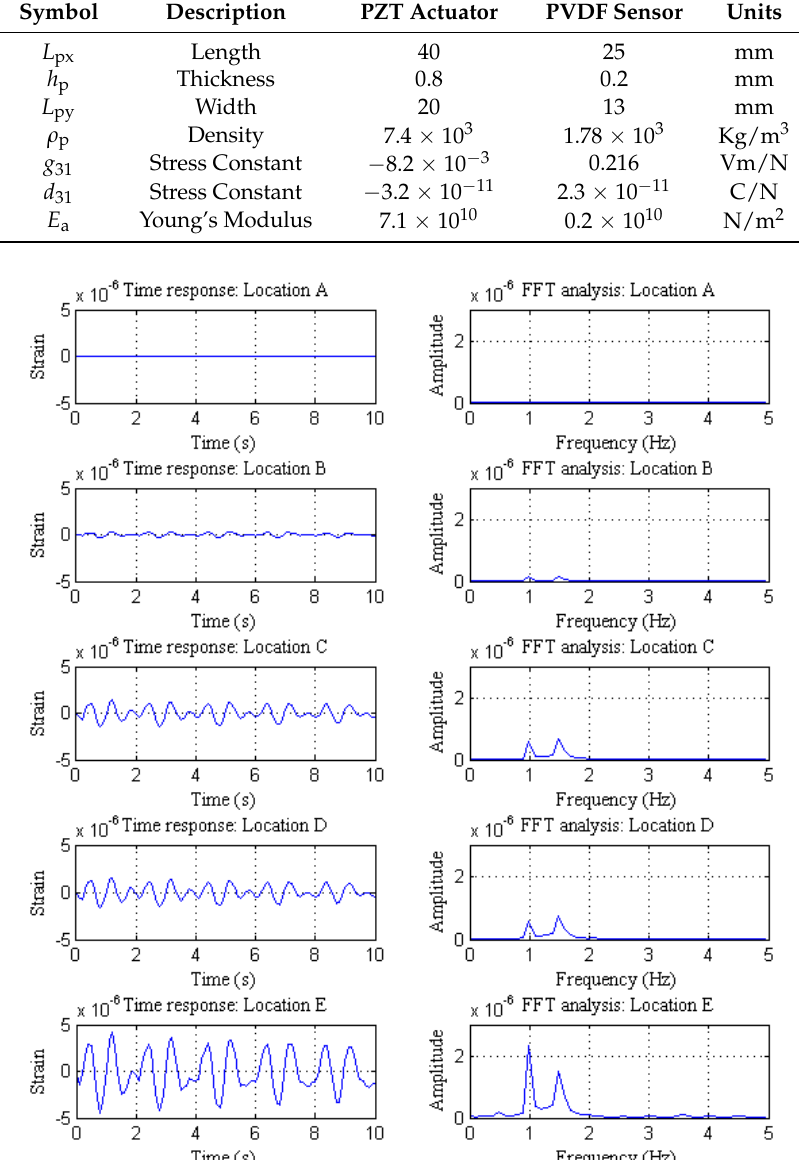
Figure 9. Modal analysis of flexible structure under persistent excitation. Subplots in the left column show the time responses at each location; subplots in the right column show the corresponding FFT results.